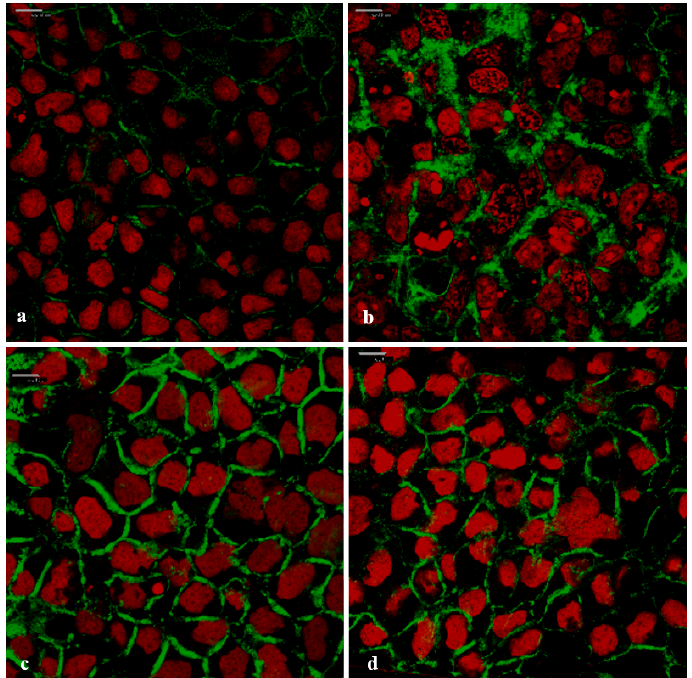
Figure 9. Confocal micrograph images of the filamentous actin (F-actin) distribution in the Caco-2 cell monolayers ( green : F-actin stained with CytoPainter ® Phalloidin iFluor 488 and red : cell nuclei stained with propidium iodide). ( a ) Negative control (untreated Caco-2 cell monolayer), ( b ) positive control (0.5% w / v TMC), ( c ) 1.0% w / v A. vera gel, and ( d ) 1.0% w / v A. vera whole-leaf extract (Scale bars represent 10 μ m).